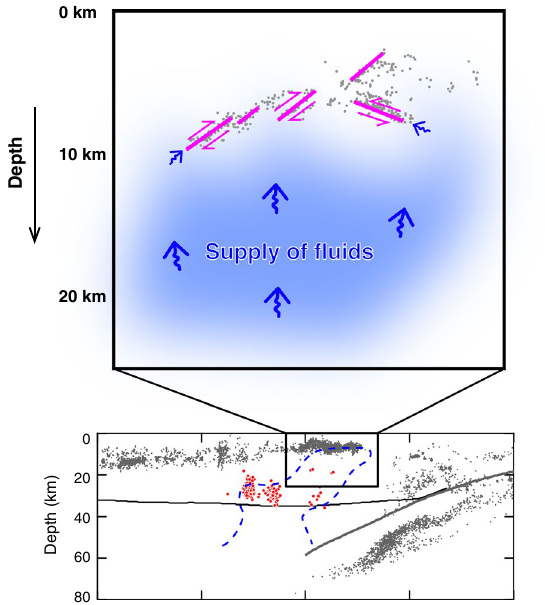
Fig. 12 Schematic cartoon of the upward migration of slab-derived fluids to the seismogenic zone and their infiltration into individual faults. Earthquake swarm is triggered by shear slip along individual